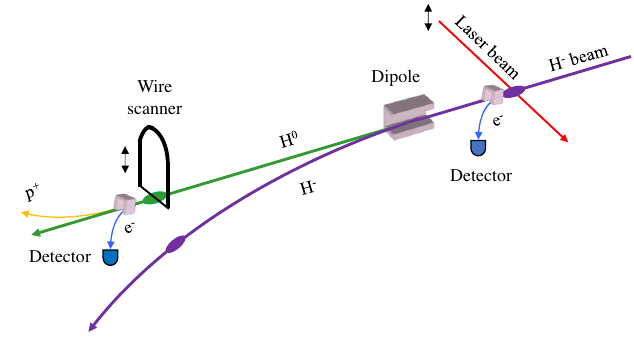
FIG. 2. Schematic of laser-based H − beam transverse emittance